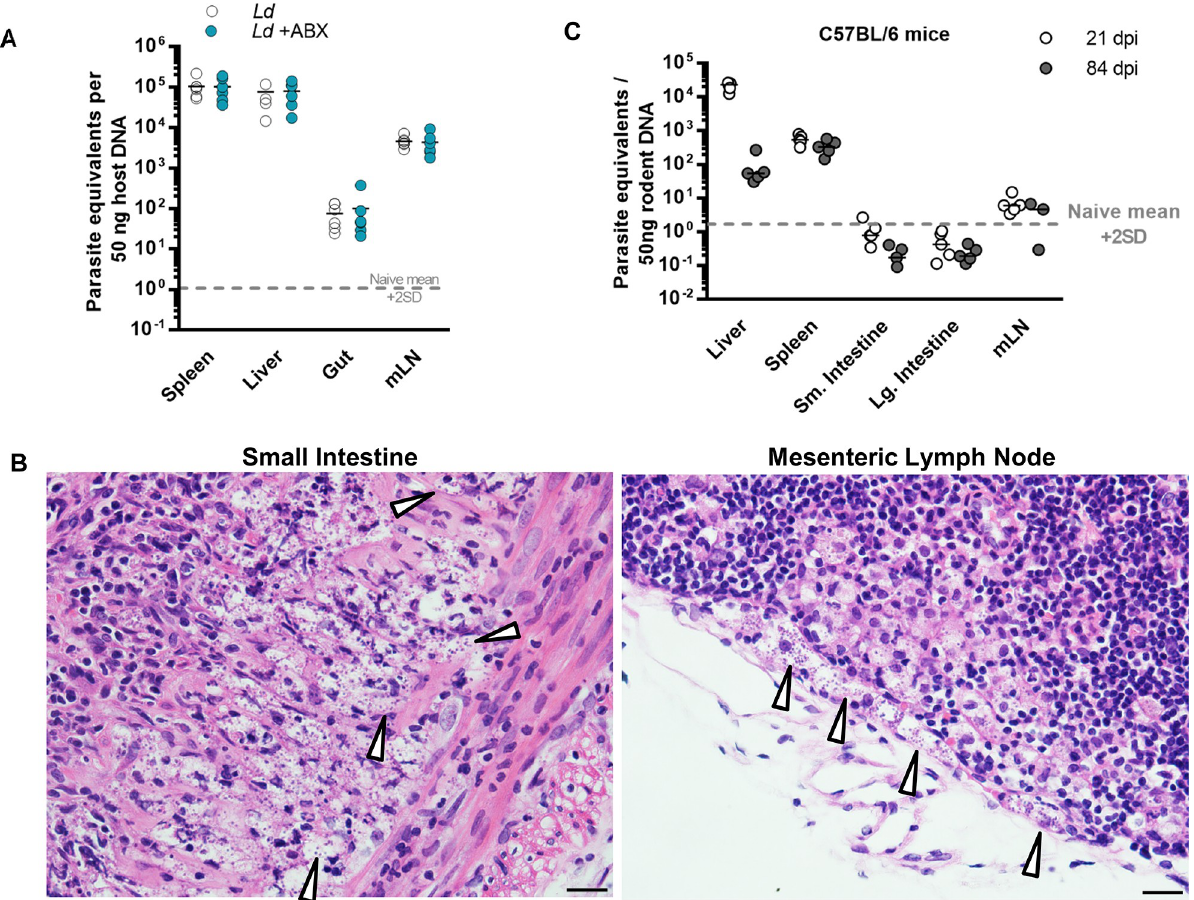
Fig 8. The GI tract is a site of chronic L . donovani infection in hamsters but not mice. (A, C) qPCR analysis of L . donovani parasite loads in tissues from hamsters (A) and mice (C). Parallel reactions for a parasite-specific target (kDNA minicircle) and a host-specific gene ( Actbl2 ) were performed on DNA extracted from the indicated tissues at 84 days post-infection (dpi) for hamsters (n = 6 per group) and 21 and 84 dpi for mice (n = 3–5 per group). Lines show medians and dashed line shows the detection limit (mean + 2 standard deviations of uninfected control samples, n = 4). (B) Histological sections for hamster small intestine (left, centre) and mesenteric lymph node (right) stained with haematoxylin and eosin; arrows indicate amastigote forms of L . donovani; magnification 400X, scale bars 20 μ m.